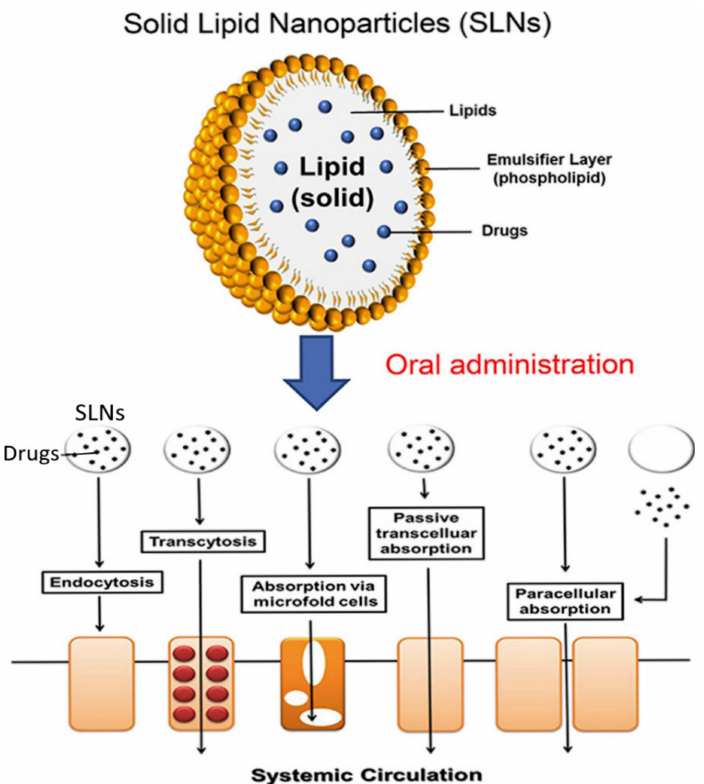
Figure 4. Mechanism of oral solid lipid nanoparticles (SLN) using different routes of delivery. Encapsulation of the lipophilic moiety of phospholipids in the lipid matrix and the absorption of drugs across the gastrointestinal tract. Adapted and modified with permission from [15] Copyright (2017) Science